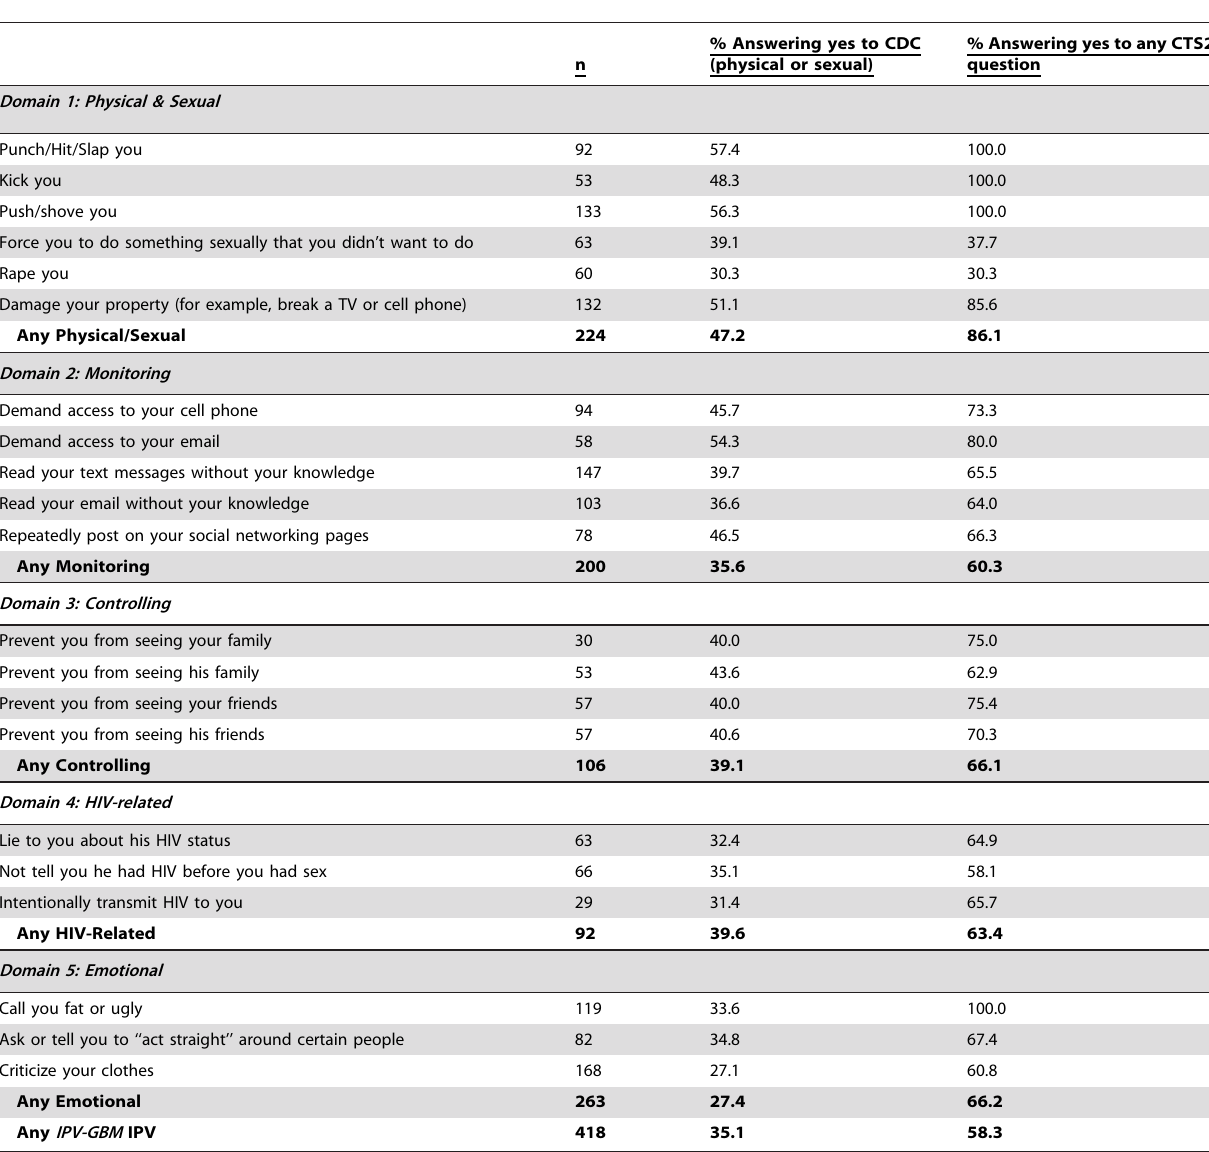
Table 5. Results of sensitivity analysis: comparisons are made between participants reporting experience of IPV based on the IPV - GBM items and domains versus both the CDC and CTS2S definitions of